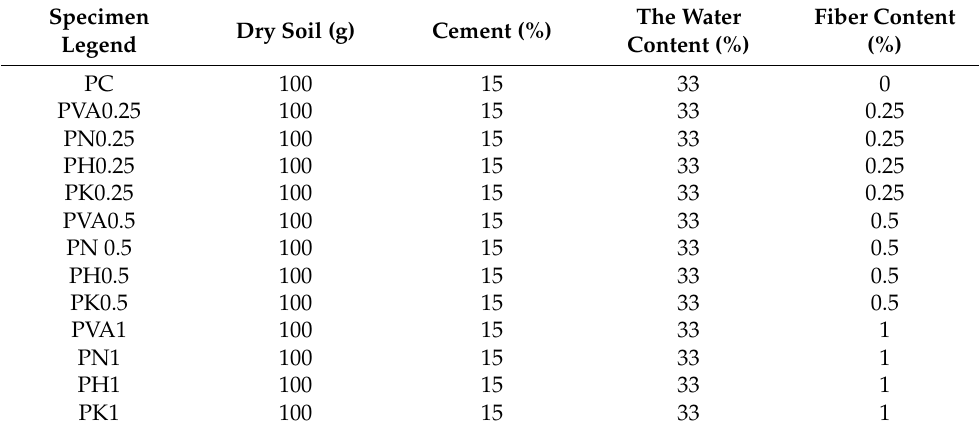
Table 4. Mixture